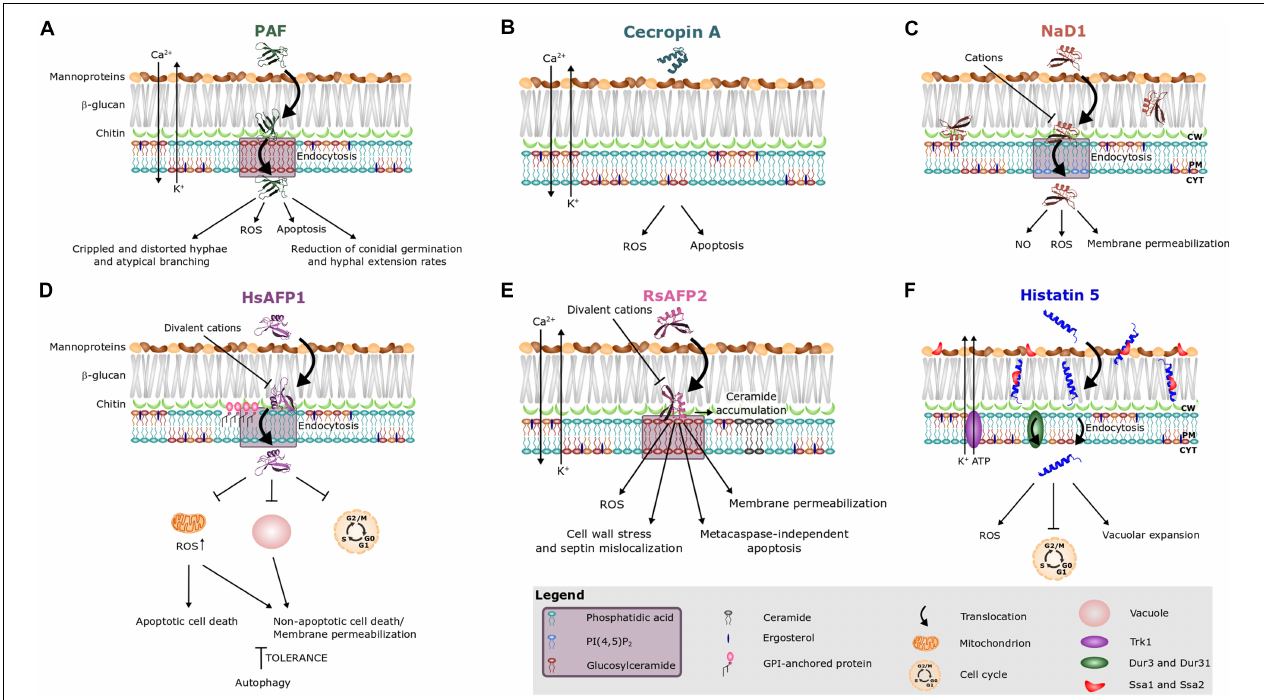
FIGURE 2 | Antifungal mode of action of (A) the Penicillium chrysogenum antifungal protein PAF and various peptides, i.e., (B) cecropin A, (C) NaD1, (D) HsAFP1, (E) RsAFP2, and (F) histatin 5. Different peptides are known to interact with different sphingo- and phospholipids, as indicated on the images and in the purple box in the legend. Note that treatment of fungal cells with rather high peptide concentrations can result in aspecific membrane permeabilization (Thevissen et al., 1997, 1999). This phenomenon is not taken into account in this